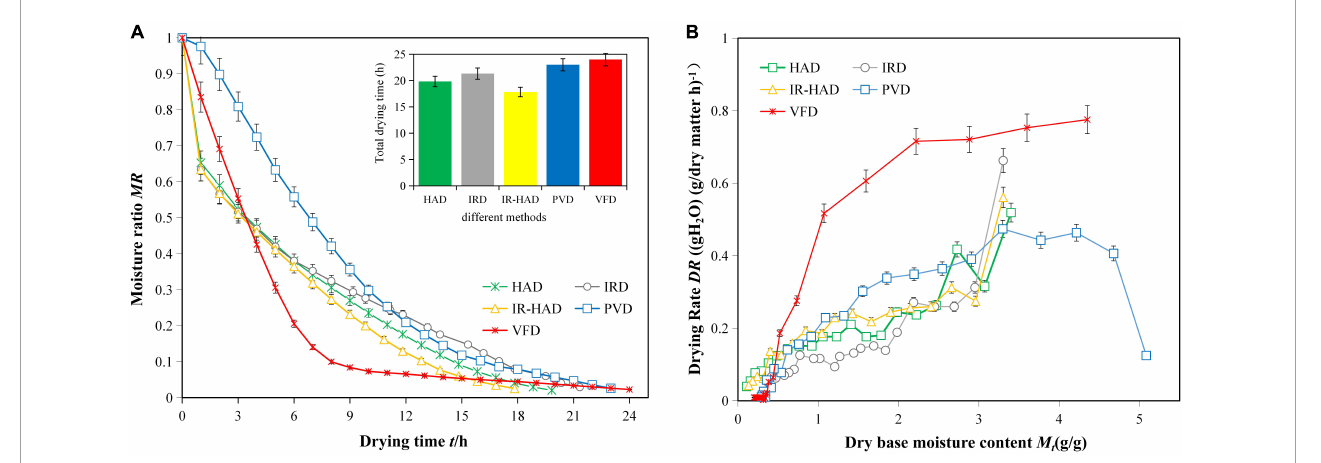
FIGURE3 (A,B) The drying curves of sea buckthorn under different drying